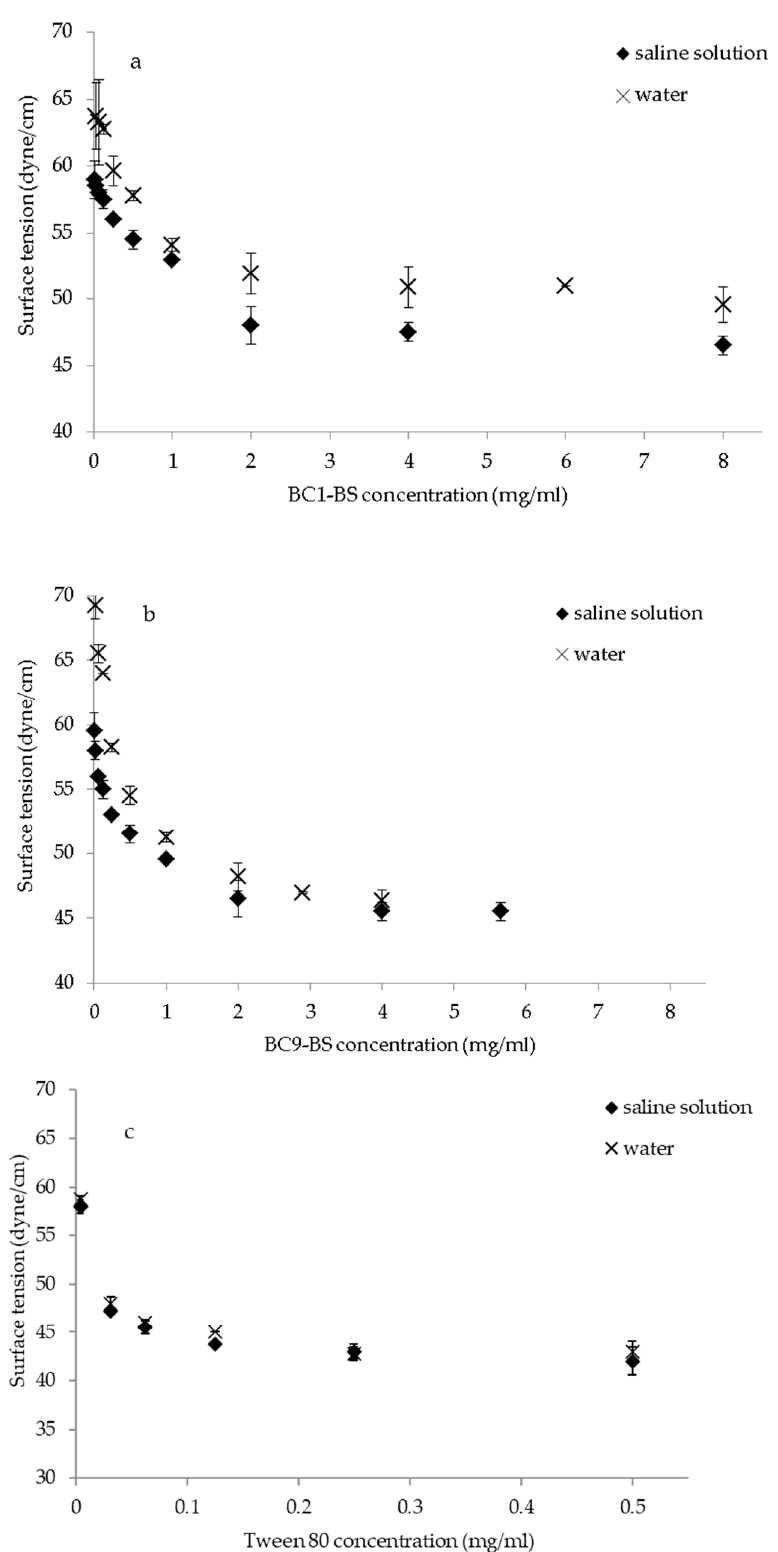
Figure 1. Surface tension values versus ( a ) BC1-BS, ( b ) BC9-BS, and ( c ) Tween 80 concentrations (mg/mL). Data are plotted as mean values of surface tension (dyne/cm) ± SD ( n = 3).